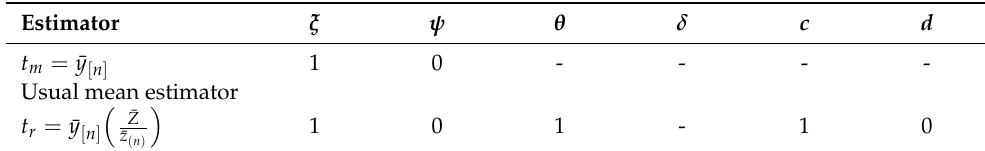
Table 1. Few available RSS estimators of the population mean ¯ Y . Estimator ξ Usual mean